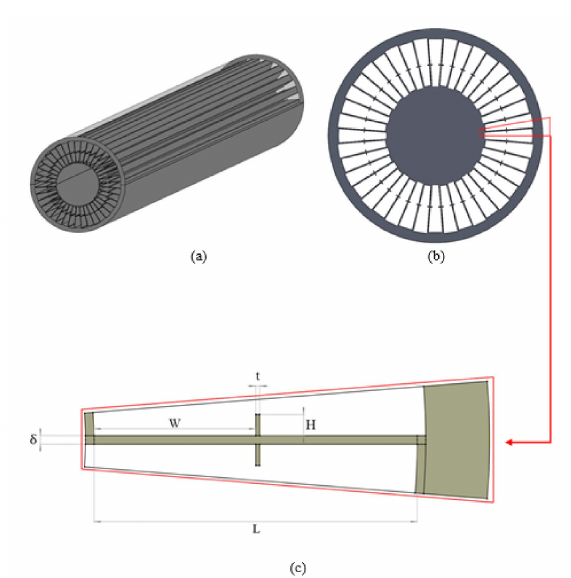
Figure 3. The physical model of design A PTHE-ZR. ( a ) three-dimensional view, ( b ) cross-sectional view and ( c ) computational